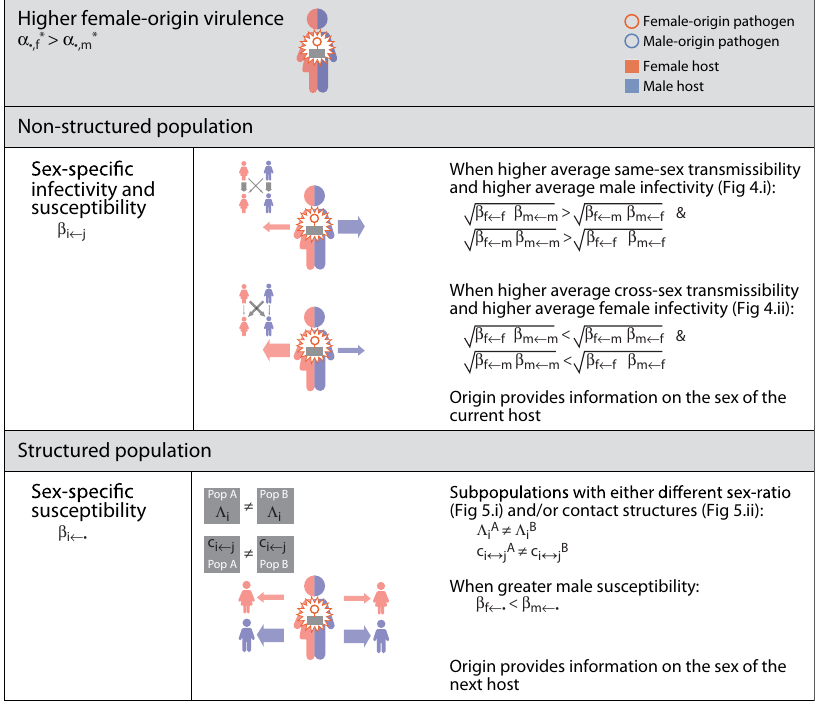
(Fig 5.i) and/or contact structures (Fig 5.ii):